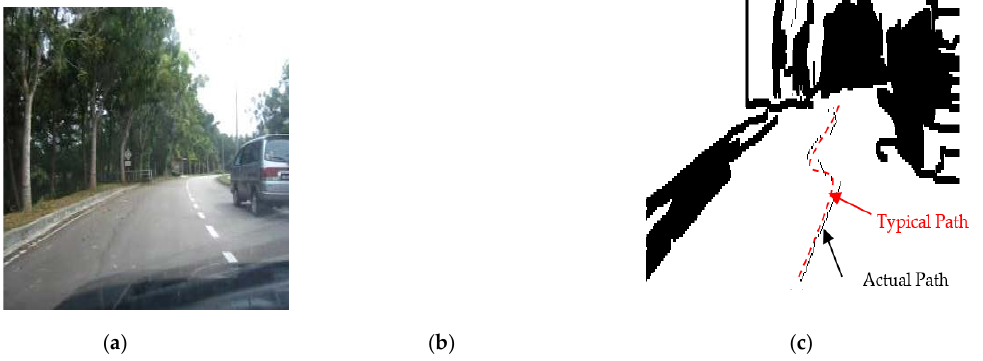
Figure 18. Autonomous detection and navigation of the proposed system in the road following (with 5 m as width and 500 m as length) a car partially presented on the side/in front: ( a ) original image, ( b ) image processing, and ( c ) generation of the path within the road following environment.